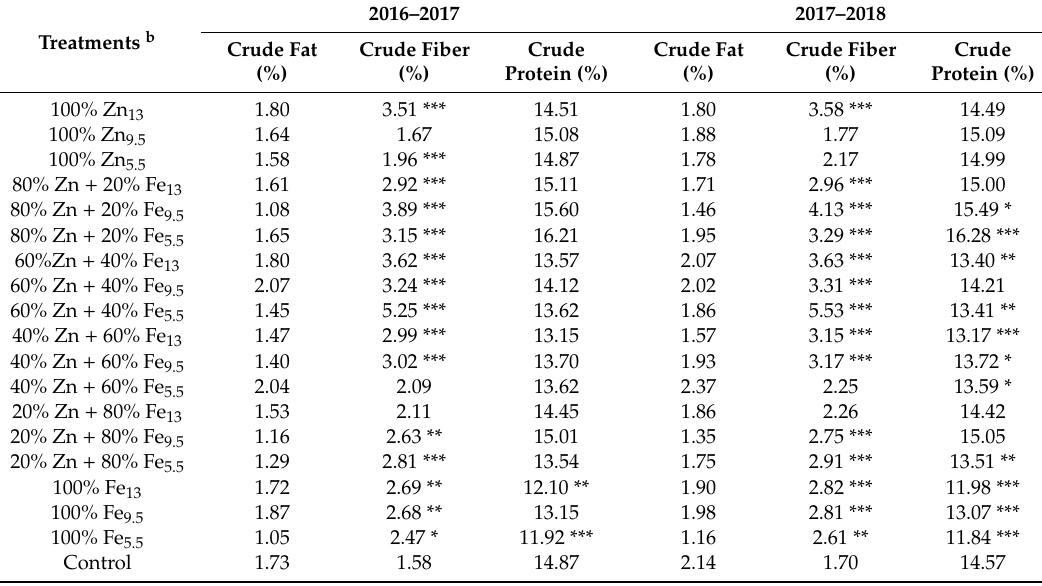
Table 4. Means comparison of crude fat, crude fiber, and crude protein of whole grain winter wheat a ff ected by foliar application of Zn and Fe fertilizers a .